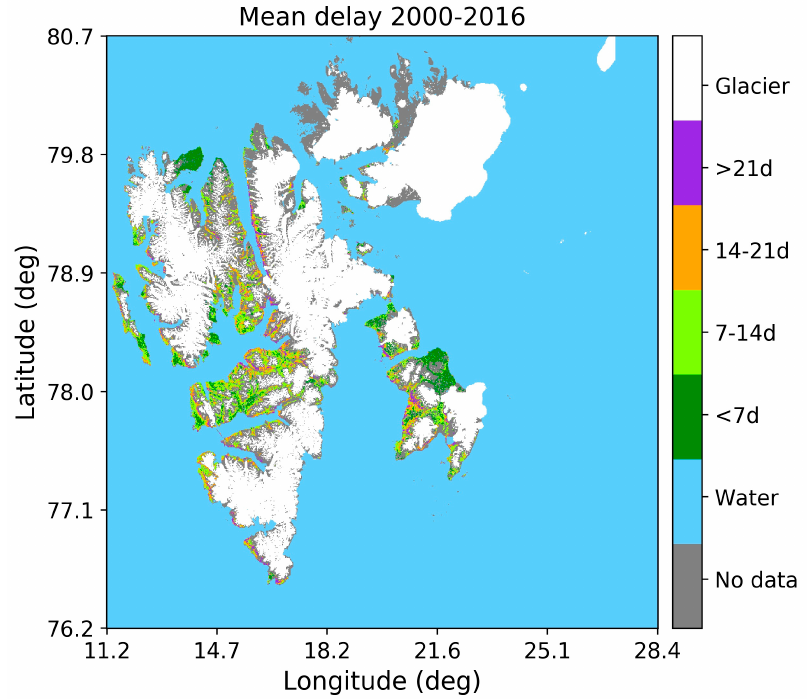
Figure 10. Mean di ff erence between growing season onset and first snow-free day, averaged Figure 10. Mean difference between growing season onset and first snow-free day, averaged over over 2000–2016.